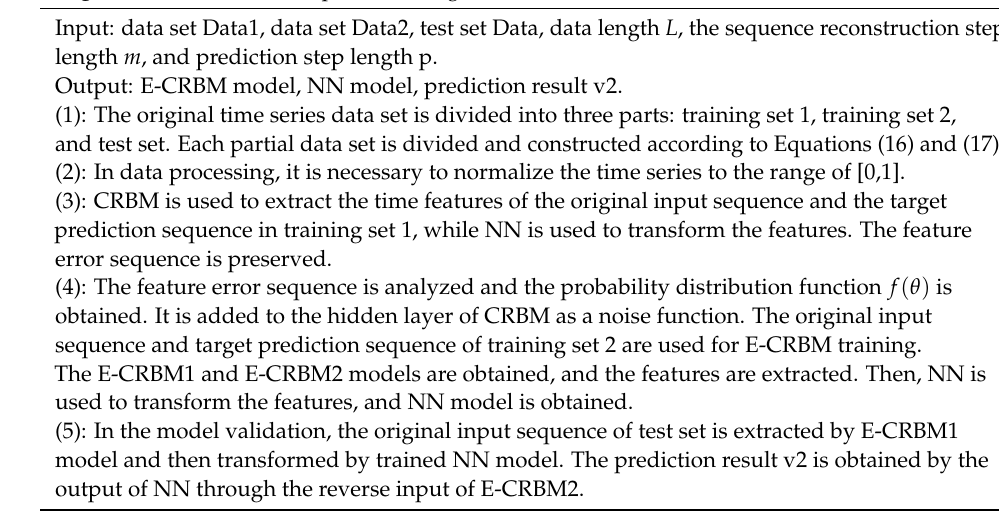
Figure 3. E-CRBM-NN learning process. Algorithm 1 E-CRBM-NN prediction